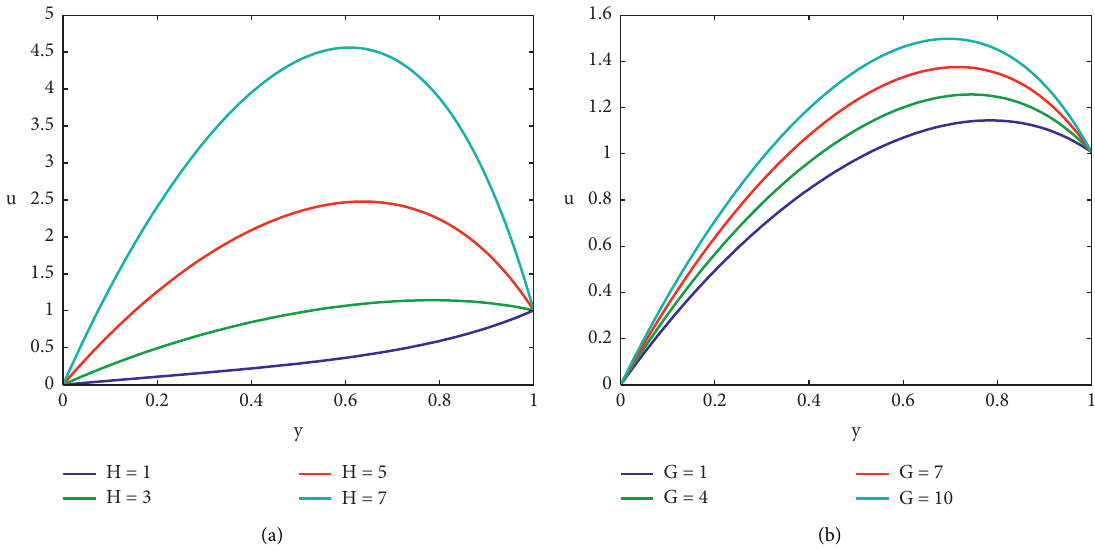
Figure 3: (a) Effect of H on the “velocity distribution” when G � 1. (b) Effect of G on the velocity distribution when H � 5.